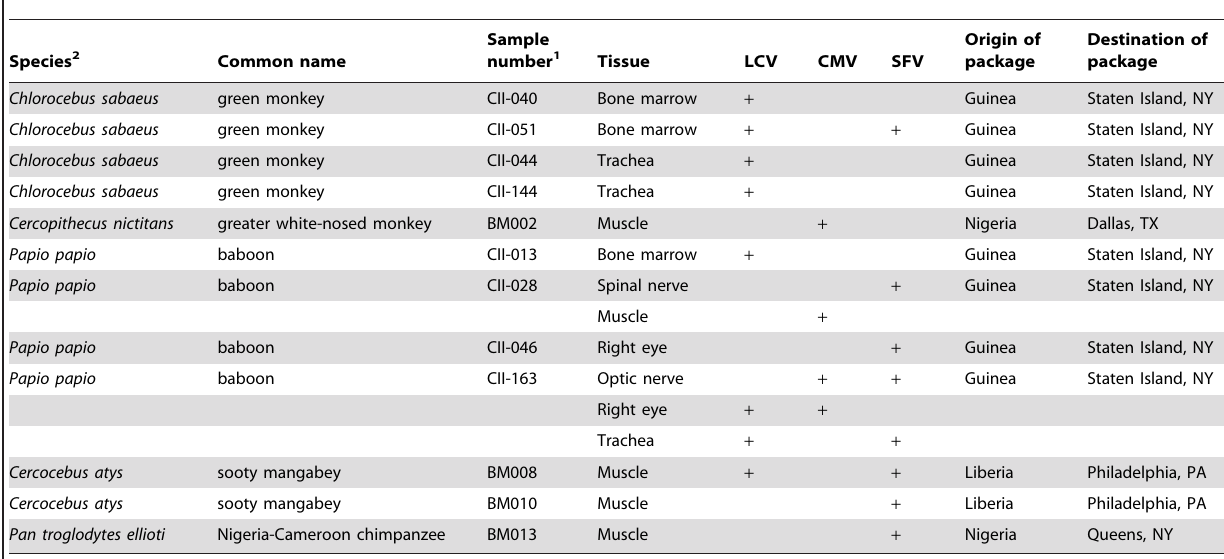
Table 1. Species identification and viruses found in smuggled nonhuman primate bushmeat samples 1